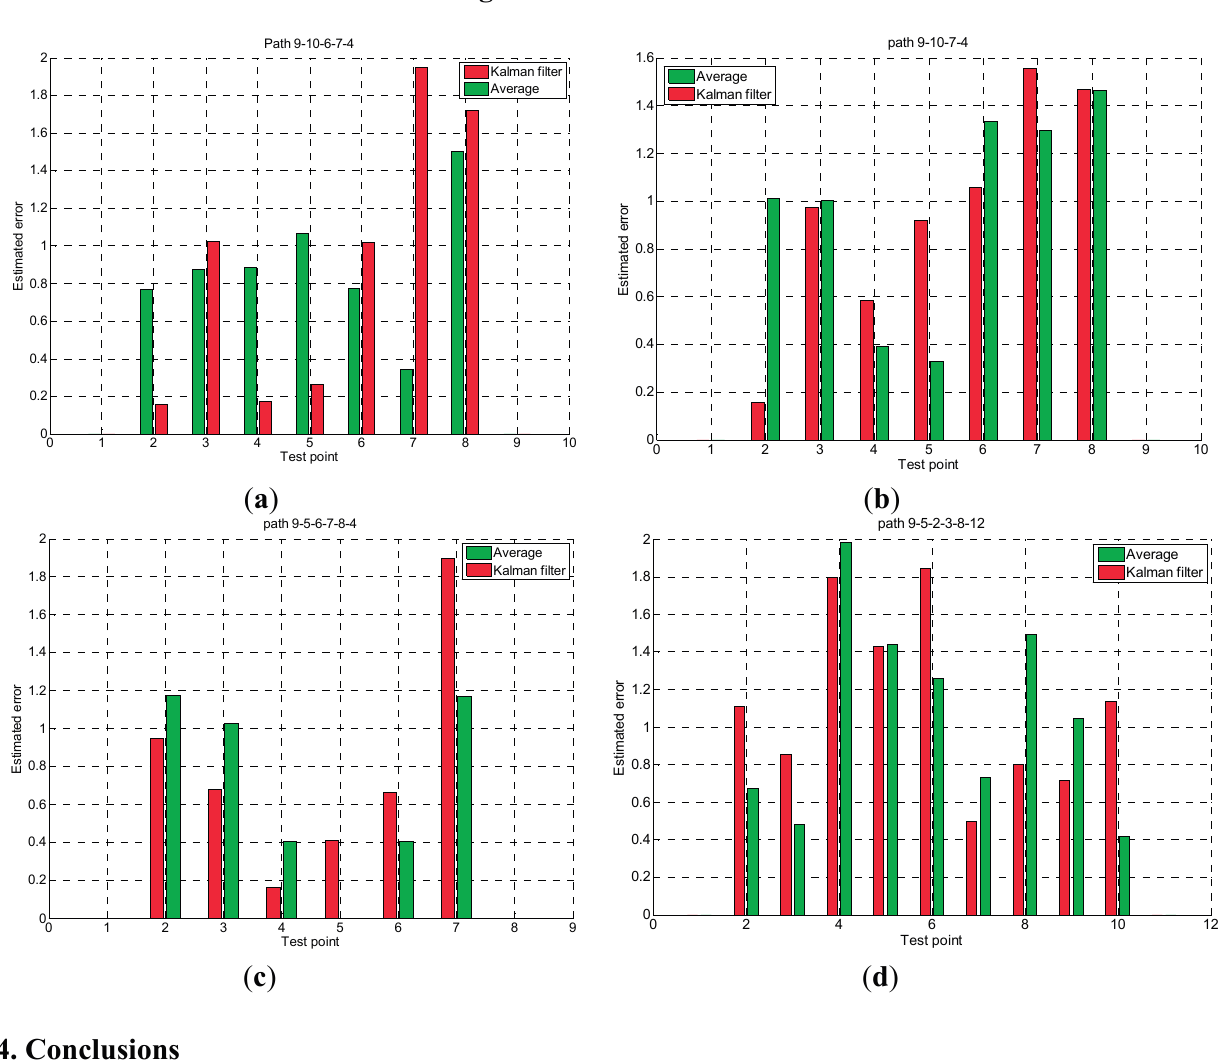
Figure 8. Estimated